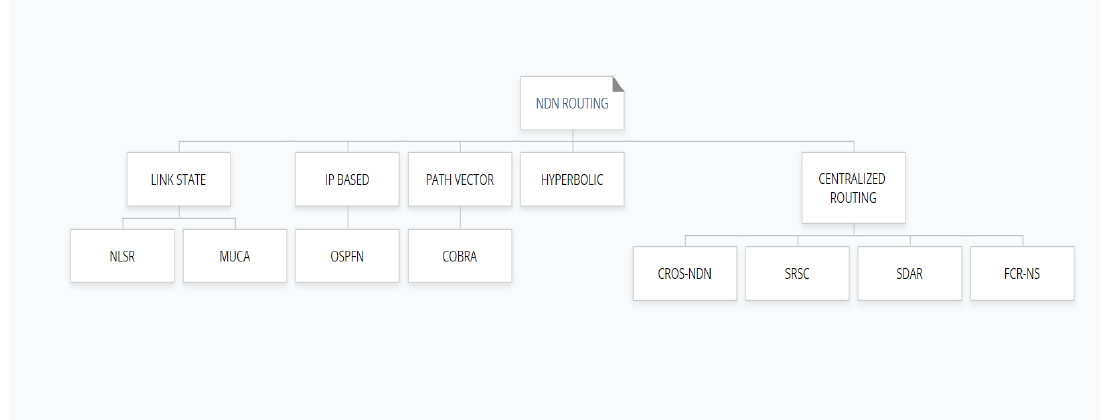
Figure 1. Classification of NDN routing